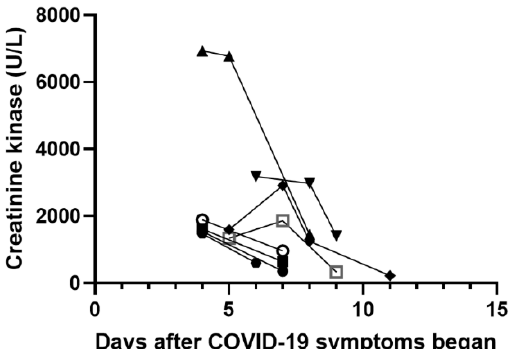
Figure 1. Changes in creatinine kinase (CK) in eight patients with rhabdomyolysis after COVID-19 symptoms began. The trends of individuals’ CK level were shown by the solid lines.